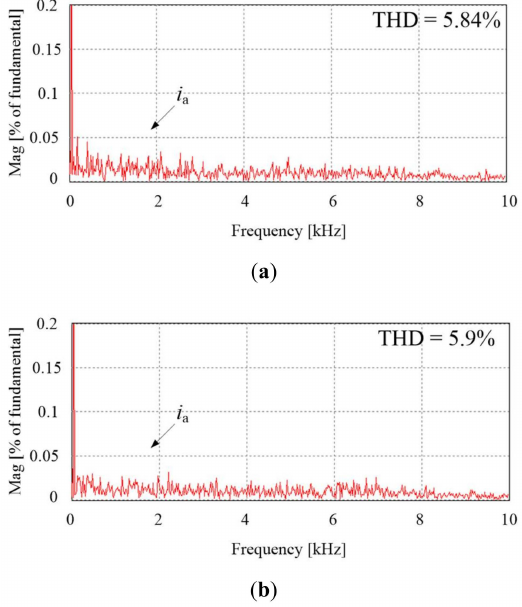
Figure 7. Simulation results of the fast Fourier transform (FFT) analysis of a -phase source current obtained from ( a ) the conventional method and ( b ) the proposed